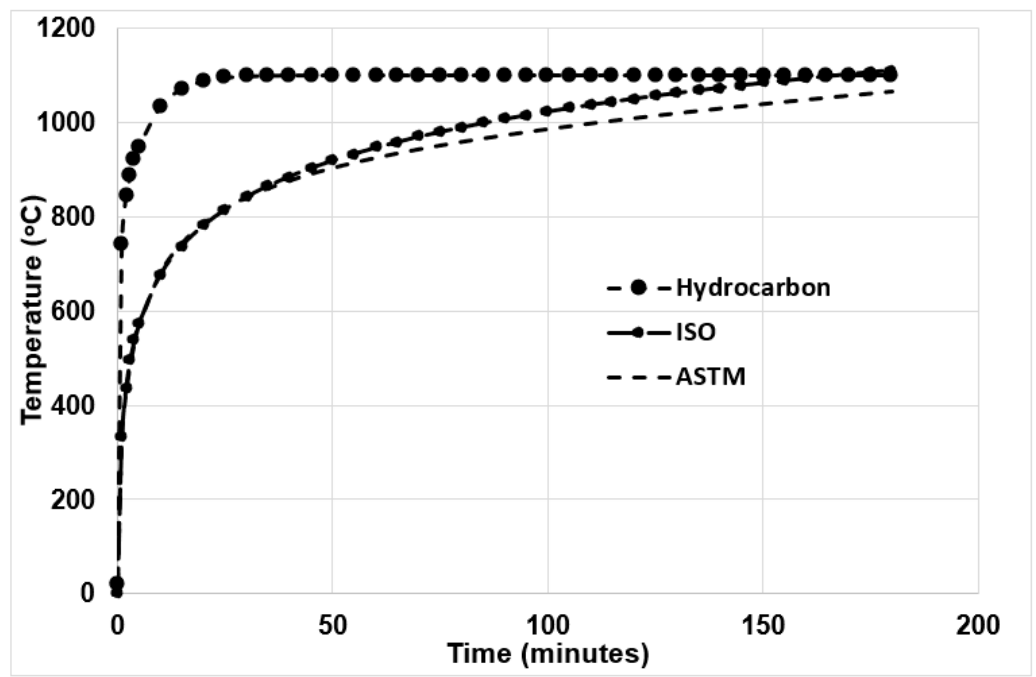
Figure 1. Standard fire curves.